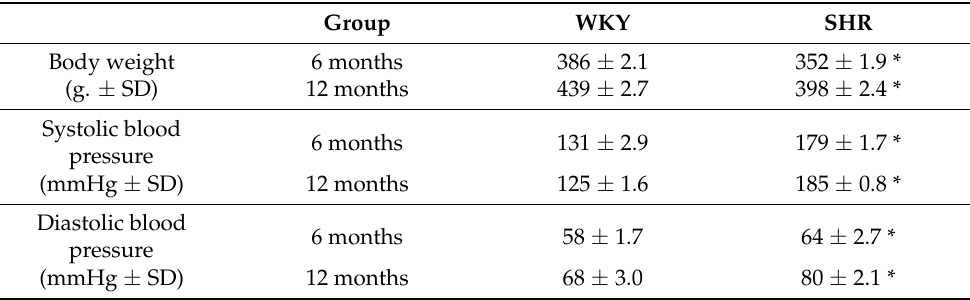
Table 2. Mean values of body weight, systolic blood pressure (SBP), and diastolic blood pressure (DBP) in the 6 months and 12 months groups of WKY and SHR rats. The SAP and DAP were measured by a tail-cuff method with the rats under conscious conditions using a noninvasive blood pressure measurement system. SBP and DBP were determined 3 times blind to the randomization sequence on each time point, and the mean values were used as the result. The same evaluator always took SAP and DAP measurements. The differences between WKY and SHR were significant when applied to a T-student test (* p < 0.05). Group WKY SHR Body weight 6 months 386 ± 2.1 352 ± 1.9 * (g. ± SD) 12 months 439 ± 2.7 398 ± 2.4 * Systolic blood 6 months 131 ± 2.9 179 ± 1.7 * pressure 125 ± 1.6 185 ± 0.8 * 64 ± 2.7